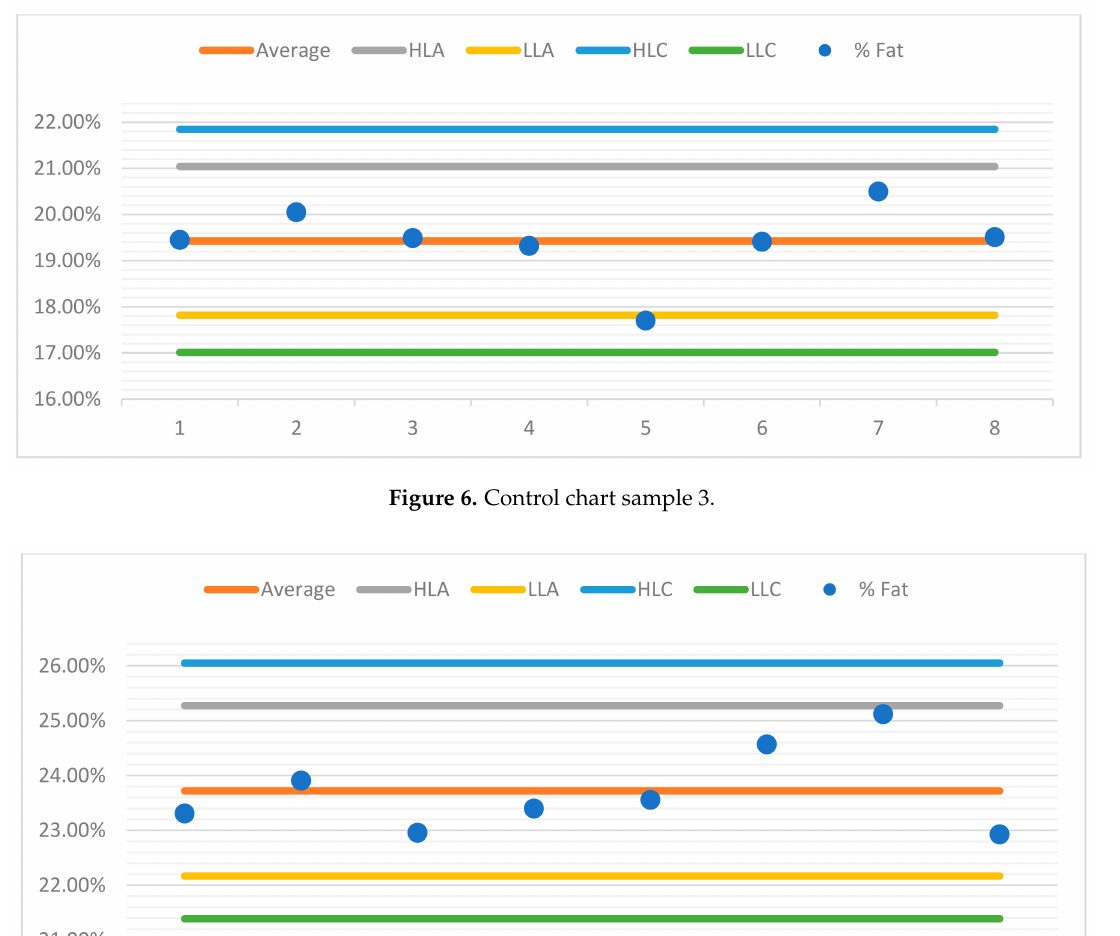
Figure 5. Control chart sample 2.